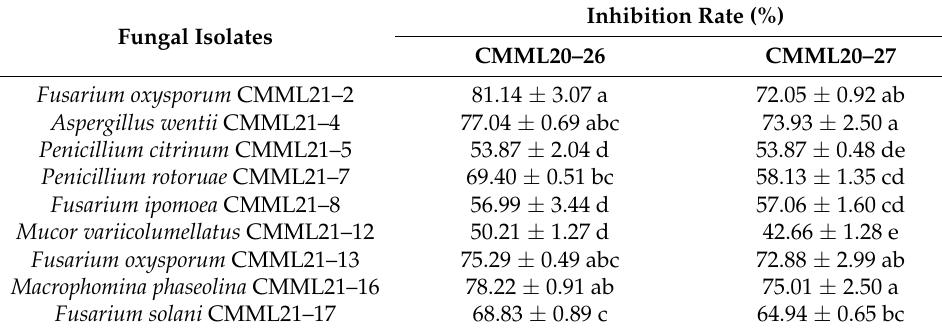
Table 3. Antifungal activity of Trichoderma harzianum strains CMML20–26 and CMML20–27 against all the pathogenic species recovered in the present study.